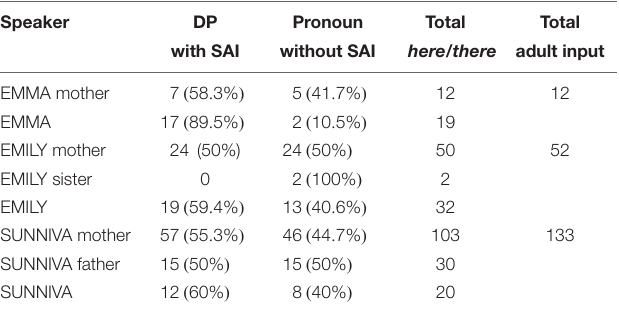
TABLE 11 | The use of + / − SAI in topicalisations with here/there adult and child speakers in the corpora. Speaker DP Pronoun Total with SAI without SAI